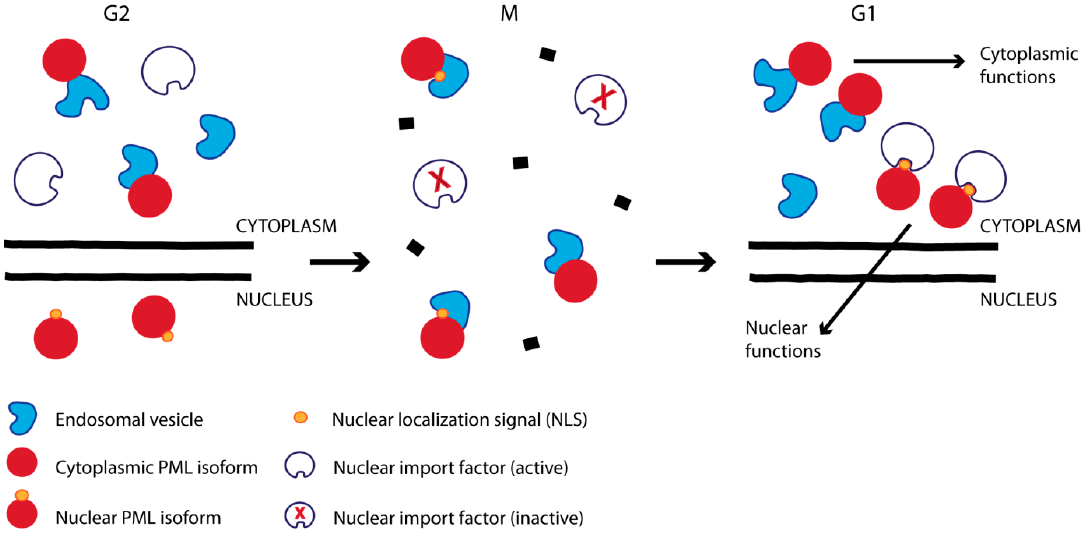
Figure 3. Cell compartment sorting of cytoplasmic and nuclear PML isoforms during progression through mitosis: NLS-containing PML isoforms are directed to the nucleus during interphase but associate with endosomes in mitosis due to nuclear import inactivation. Cytoplasmic PML splice variants, which lack an NLS, retain their association to cytoplasmic compartments (such as endosomes) throughout the cell cycle.